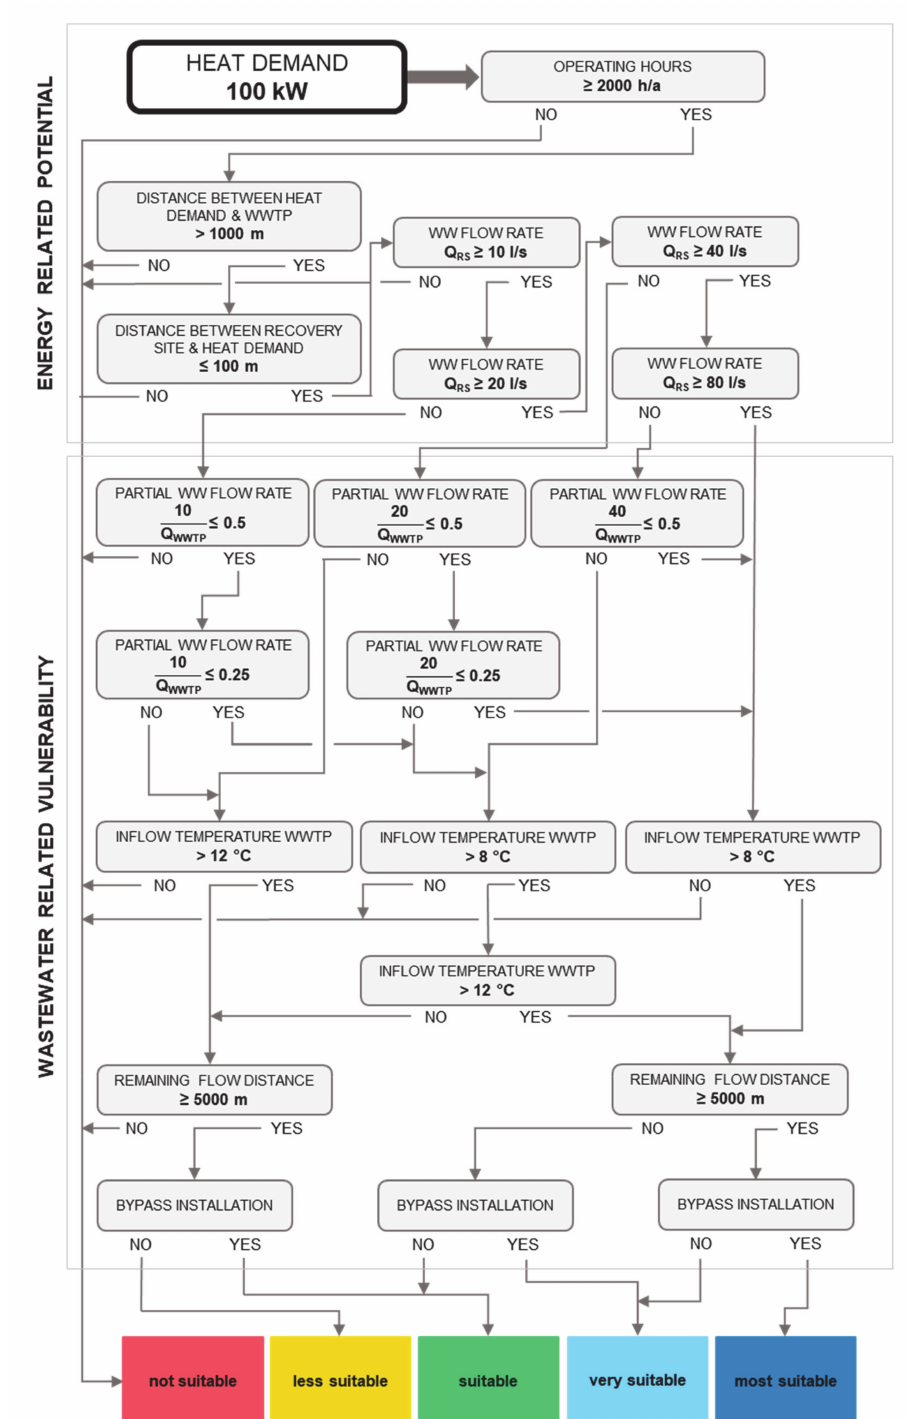
Figure A1. Relevance tree for an intended heat supply of 100 kW (own representation, based on